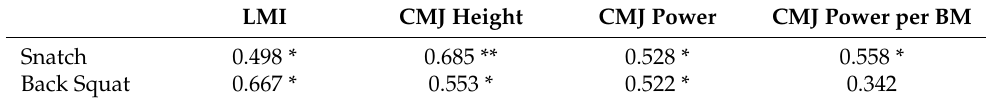
Table 2. Correlation coefficients between snatch and back squat with LMI and CMJ ( n = 16).